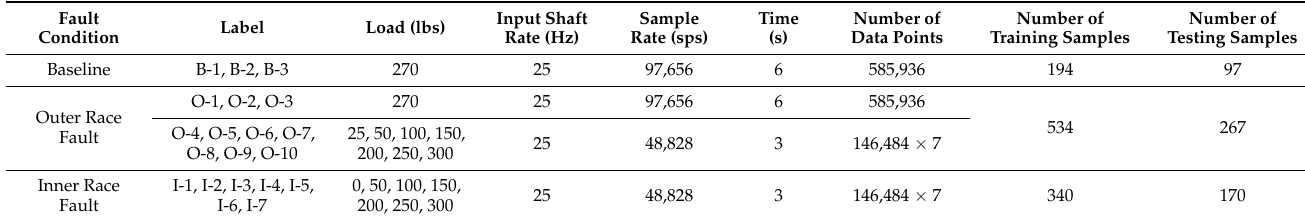
Table 1. The parameters of MPFT dataset.